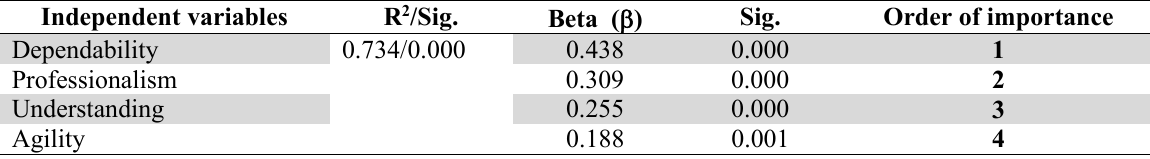
Regression results for relative importance of dimensions of scale Independent variables R 2 /Sig. Beta (  ) Sig. Order of importance Dependability 0.734/0.000 Professionalism Understanding 0.255 Agility